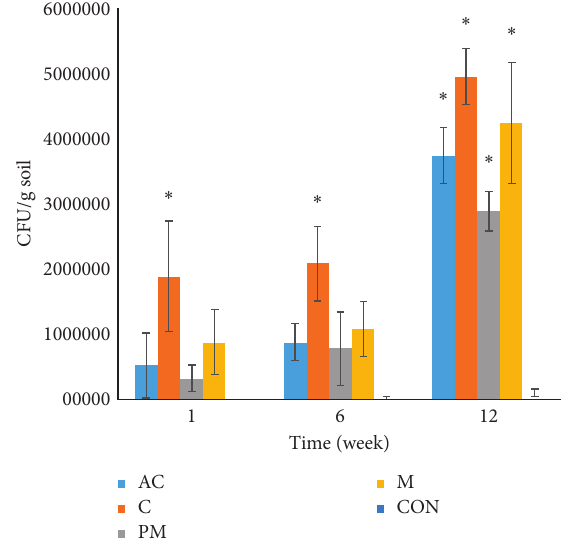
Figure 7: Total soil population bacterial counts over 15weeks as a function of treatment. M: molasses; C: plant compost; PM: papermill sludge; AC: activated carbon; and CON: control. ( ∗ ) indicates that data for the treatment were significantly different ( p < 0.05) from the